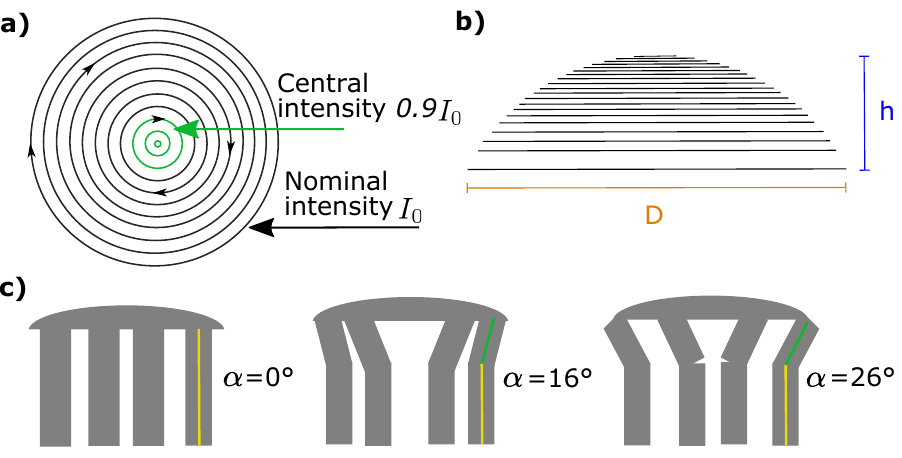
Figure 2. Fabrication strategy characteristics: ( a ) Top view of micro-lens fabricated by concentric circles with tunable intensity (within the central part of the scanning, a 10% decrease in nominal value I 0 was applied); ( b ) schematic of micro-lens design parameters; ( c ) micro-structure design: supports: consisting of two parts (marked in yellow straight and green color for the tilted part) to adjust the pre-compensation angle α of the micro-lens